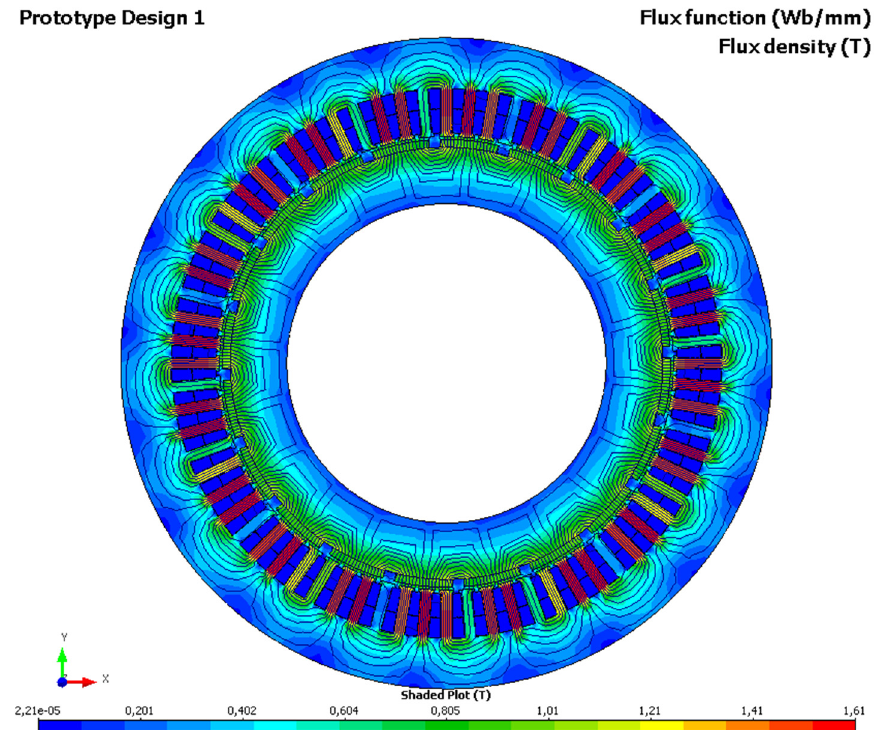
Figure 19. Magnetic field distribution of generator.